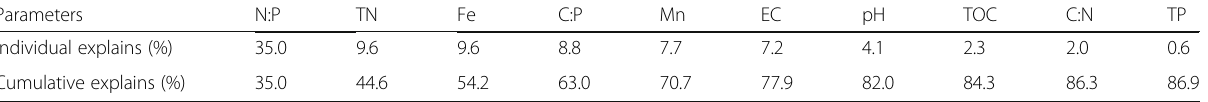
Table 3 The interpretative capacity of physico-chemical parameters to HM-fractions based on RDA analysis